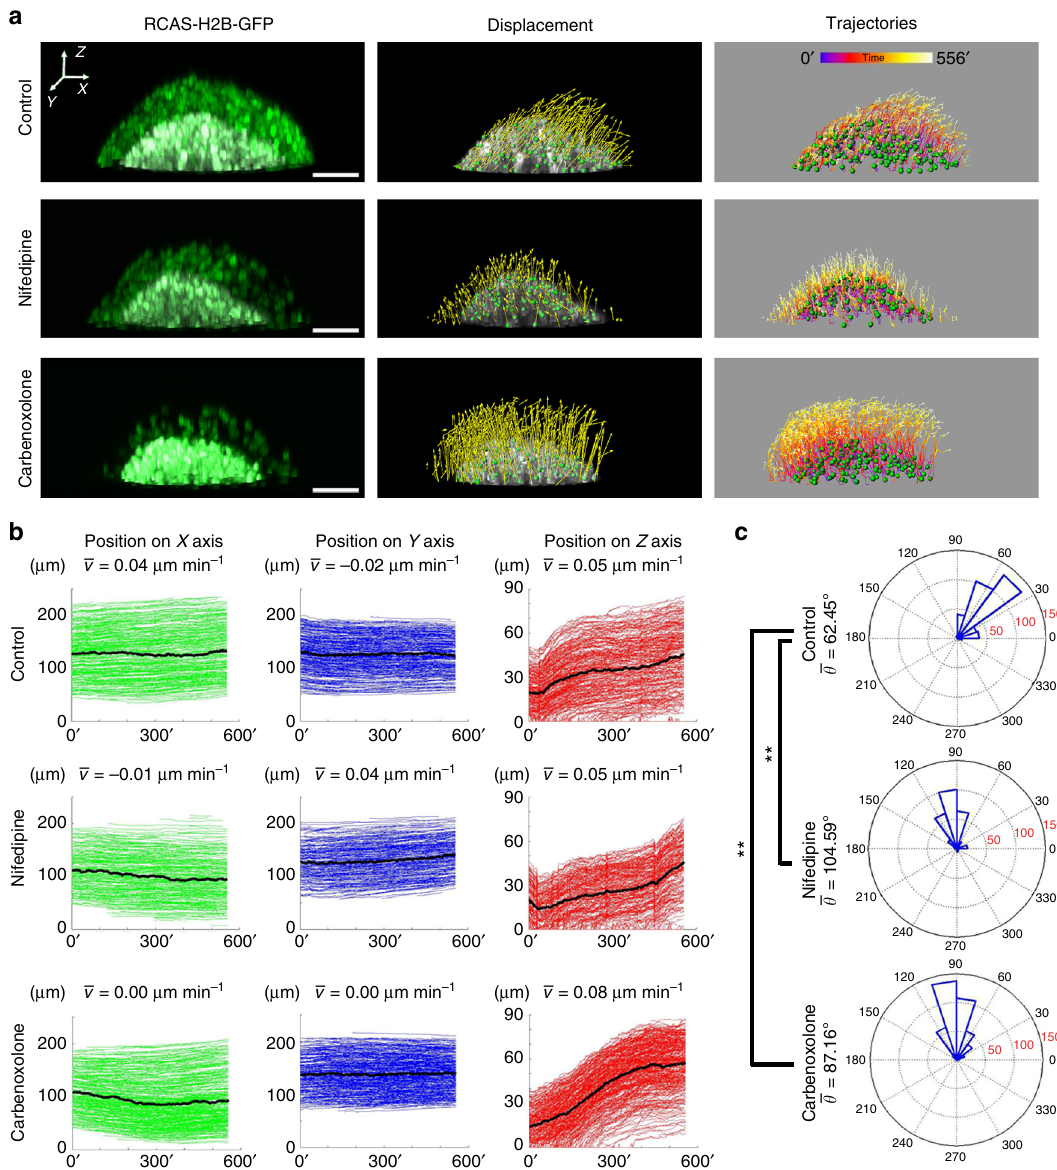
Fig. 6 Altered feather mesenchymal cell migratory patterns upon inhibition of VGCCs and gap junctions. a 4D cell nucleus (H2B-GFP) imaging of elongating feather buds on H&H 34 skins. Left-most panel, 3D rendering of the feather buds at Time 0, with the mesenchyme highlighted in white. Middle panel, Mesenchymal cell nuclei were segmented (green dots) and their displacement vectors (yellow arrows) were mapped. Right panel, Cell movement trajectories. Different trajectory colors represent time ( ′ denotes minutes). Scale bar, 50 μ m. b Plotting individual mesenchymal cell positions along the X (anterior – posterior), Y (left – right), and Z axis (up – down) over time. Black line indicates averaged cell position over time. The averaged velocities ( v ̅ is the averaged displacement along the corresponding axis divided by time) are shown above each plot. c Angle histogram plots illustrate the cell displacement angle in the XZ plane (0°, 90°, 180°, and 270° represent posterior, upward, anterior, and downward directions, respectively). Cells tracked: n = 378 for controls, n = 316 for Nifedipine, and n = 278 for PMA-treated samples. The averaged displacement angles ( ϴ ̅ ) were signi fi cantly altered upon Nifedipine or PMA treatment. ** P < 0.01 (Watson ’ s U 2 by tracking individual mesenchymal cells labeled with histone-H2B in the XZ plane by calculating the inverse tangent of their dis- GFP in skin explants. Since there was a strong correlation between placement along the Z and X axes (Fig. 6c). In control skins, the Ca 2 + dynamics and feather morphology changes as shown above, feather mesenchymal cells move upward and posteriorly in a pul- we tested the effect of VGCC and Gap junction blockers on cell satile manner, meaning there are moments when the migration migration. We segmented out the feather mesenchyme to exclude halts (Fig. 6 and Supplementary Movie 28). When we compare epithelial cells, tracked cell positions over time, and plotted trajec- mesenchymal cell migration patterns in the anterior and posterior tories along the X (anterior – posterior), Y (left – right), and Z bud regions, those in the anterior half move slower than their (proximal – distal) axes (Fig. 6a). We also quanti fi ed the mean cell posterior counterparts, consistent with previous cell tracking data 16 , but their movement directions are similar (Supplementary Table 1 movement velocity by averaging every cell ’ s displacement over time and Supplementary Fig. 10a). In Nifedipine-treated skins, feather (Fig. 6b), as well as cell movement directions (displacement angle)